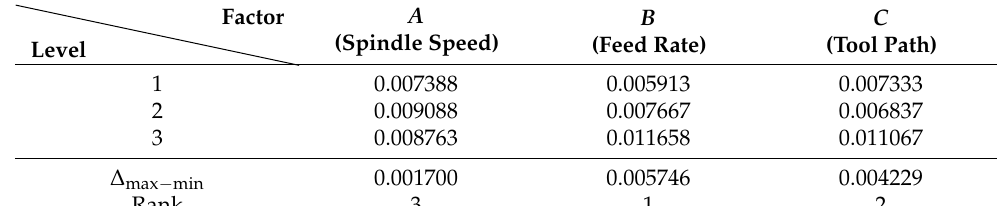
Table 11. Response table for mean values for profile errors.